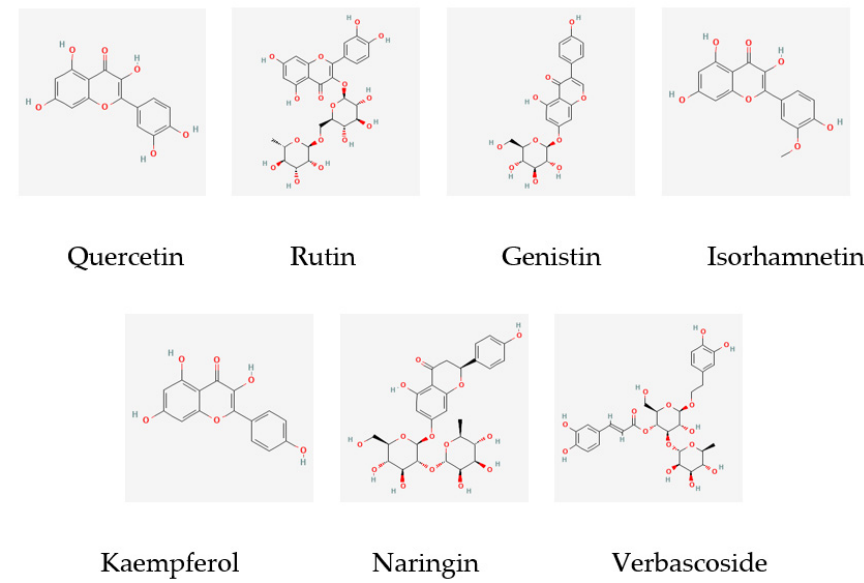
Figure 1. Molecular structure of 7 main components of osmanthus extract.